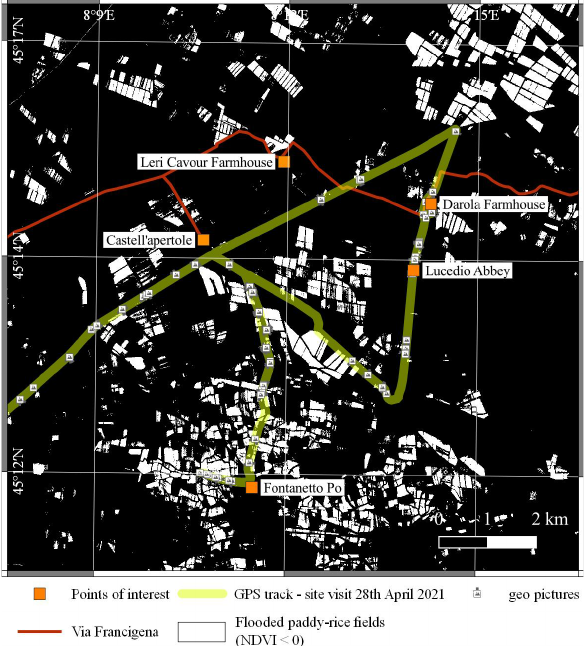
Figure 5. Mapping flooded paddy-rice fields by processing threshold NDVI < 0. The map highlights the pictures taken along the ground observation, recorded by GPS track. Sentinel-2 image 24 th April